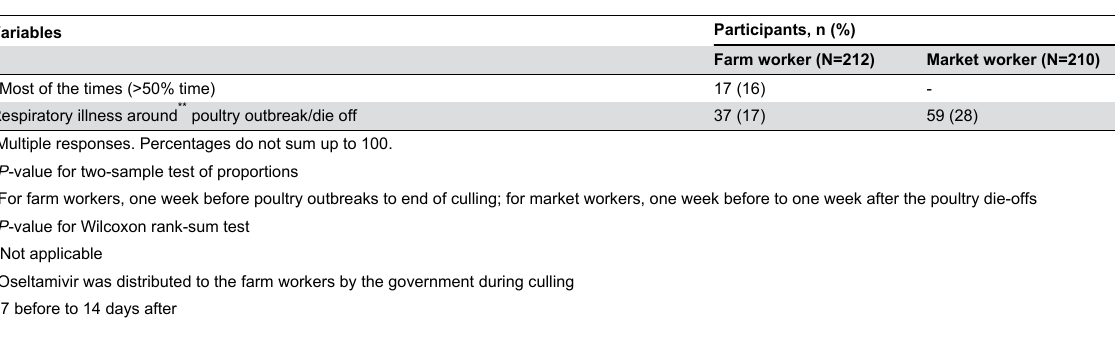
Table 3. Characteristics of live bird market workers with HPAI H5N1 virus neutralizing antibody titers <20 and ≥20 by microneutralization (MN) assay,